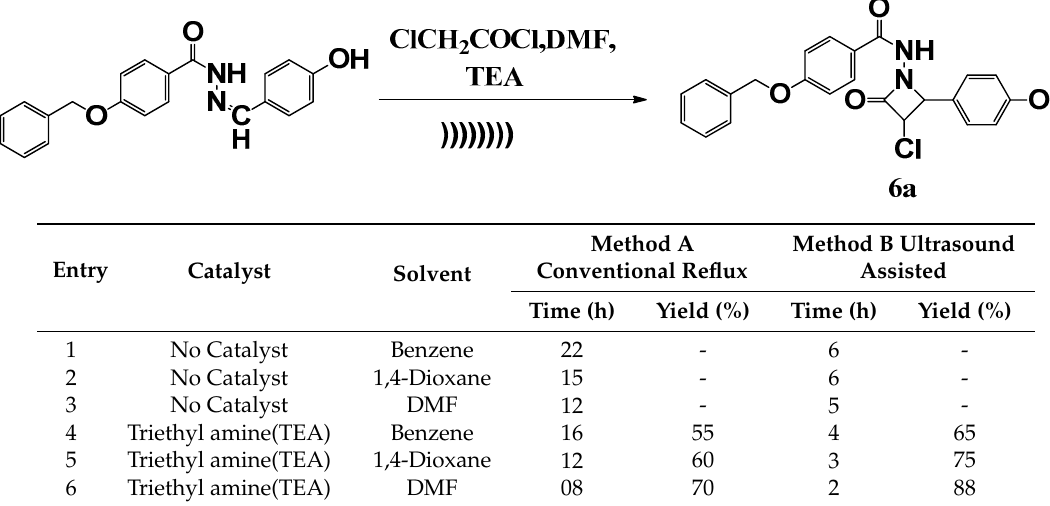
Table 2. Comparison of reaction kinetics of conventional refluxing and ultrasonic irradiation methods for the synthesized compounds 6a – j .